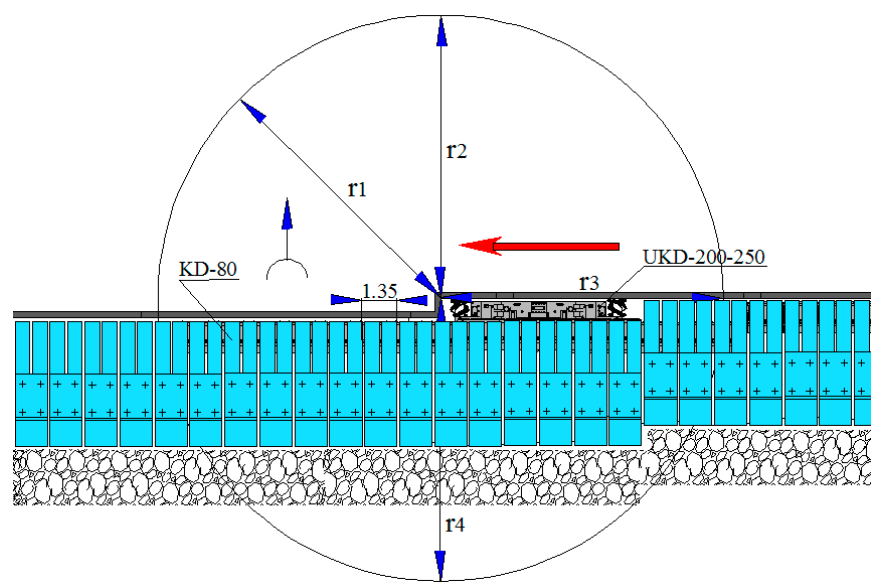
Figure 8. Configuration of a zone of shearer influence on the roof rock displacement.